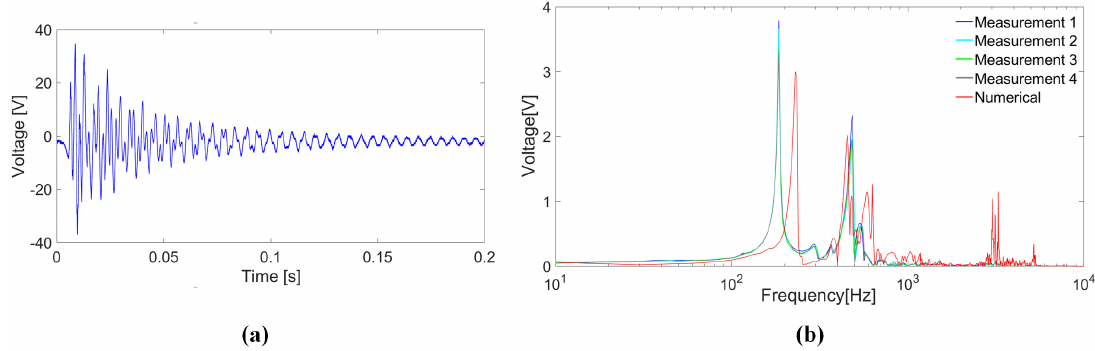
Figure 10. Open-circuit output voltage obtained during the STB test (model A): measured time history ( a ), Fourier transform of the signals compared to the numerical outcomes ( b